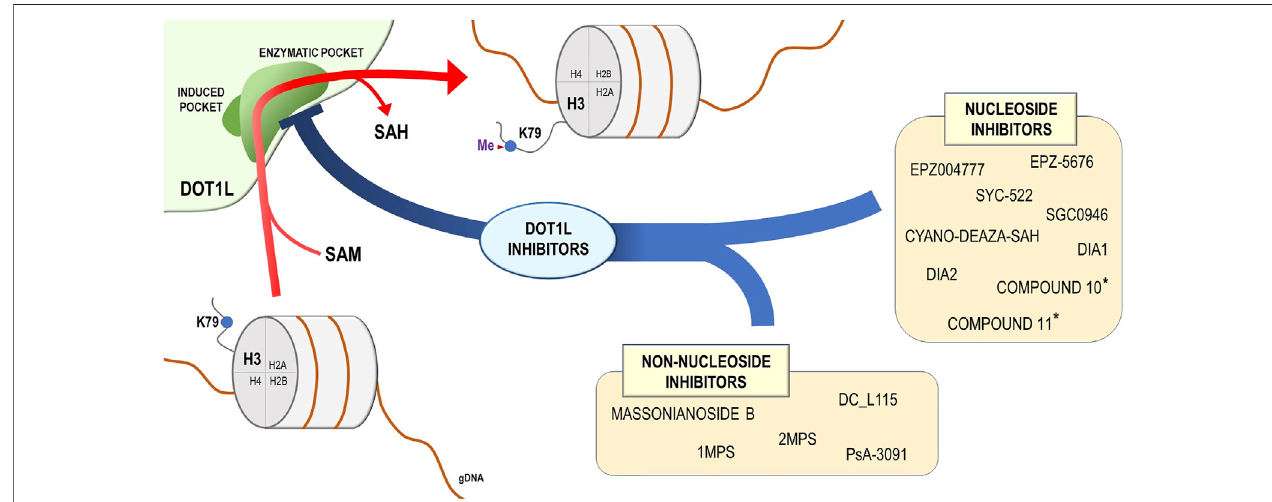
FIGURE 2 | DOT1L mechanism of action and DOT1L inhibitors. DOT1L catalyzes the transfer of the methyl group from the S-adenosyl-L-methionine (SAM) to the lysine 79 residue of the histone H3 (H3K79), introducing a methyl group and releasing the S-adenosyl-L-homocysteine (SAH). On the basis of chemical structure, the DOT1L inhibitors are subdivided into two groups: nucleoside and non-nucleoside DOT1L small-molecule inhibitors. * These compounds were described in Perner et al.